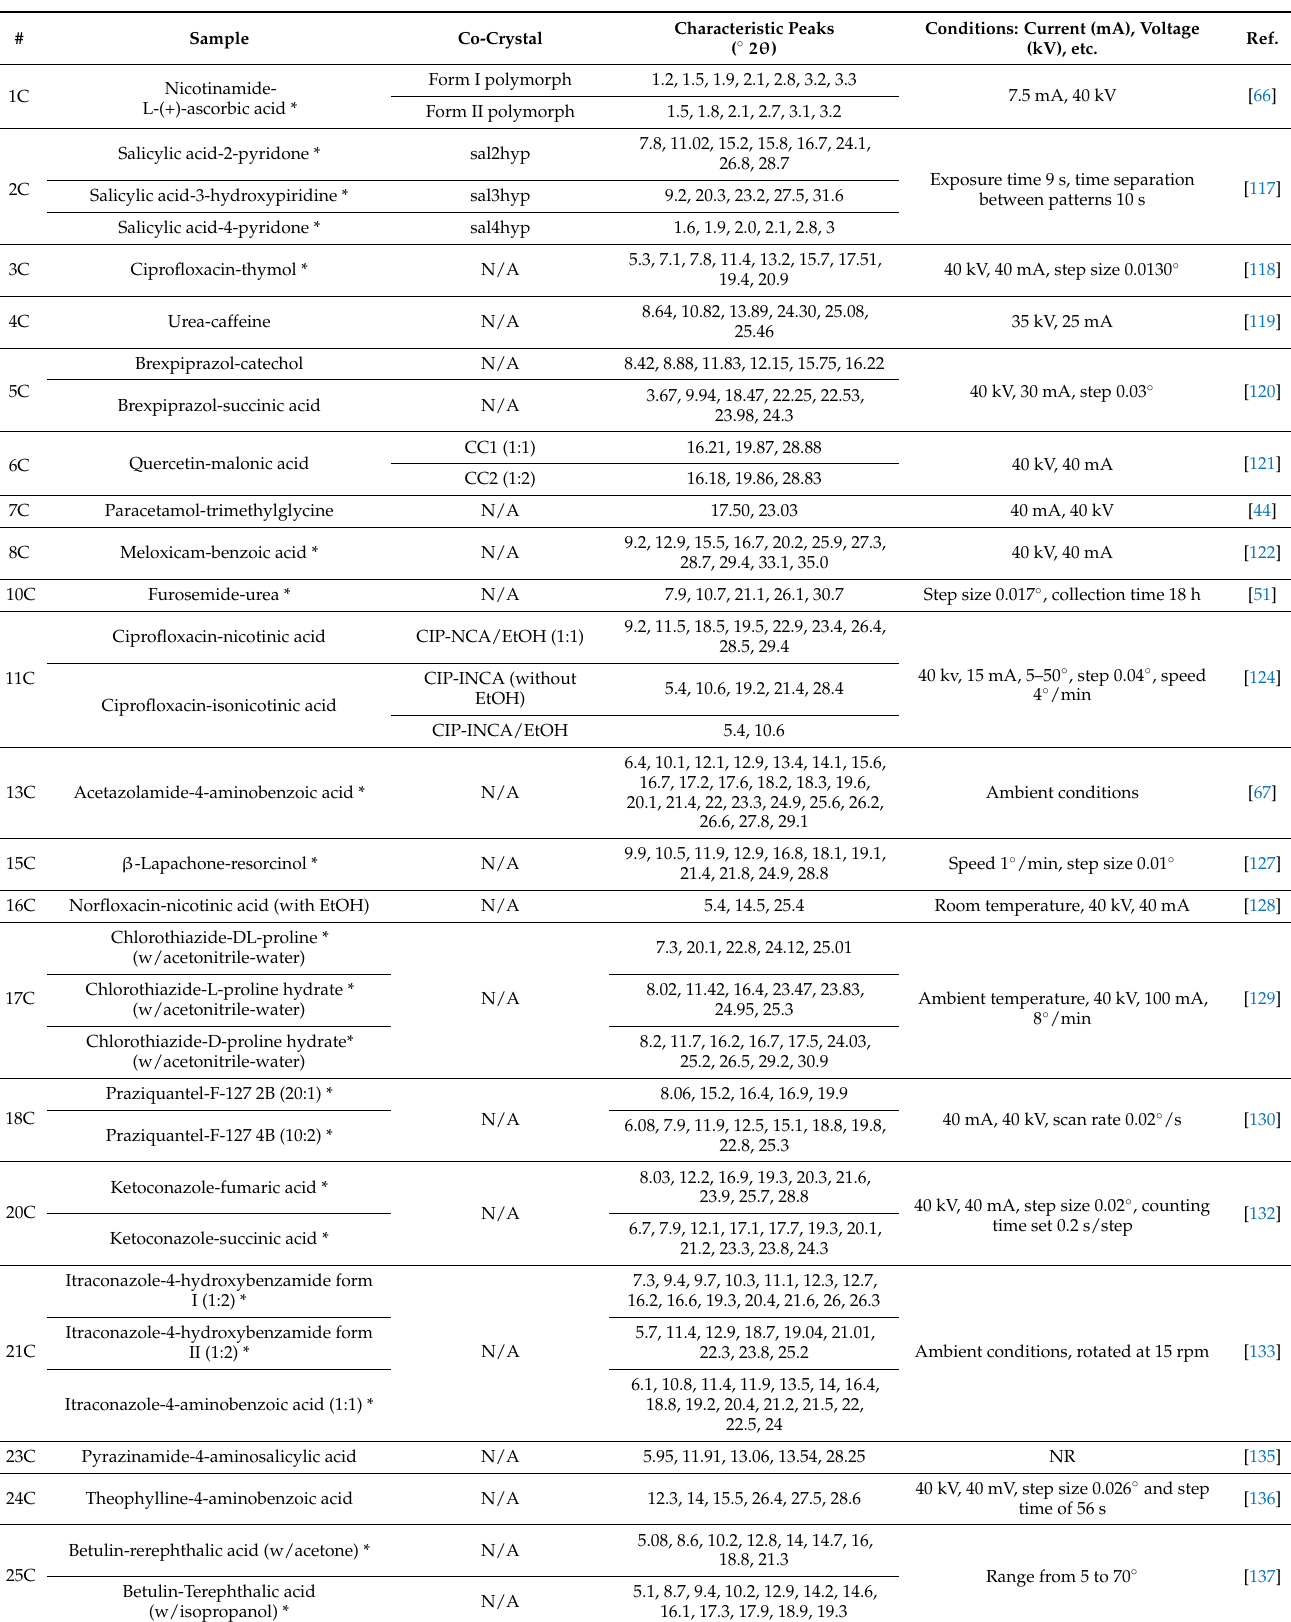
Table 12. Overview of identification of diffraction peaks and measurement conditions for